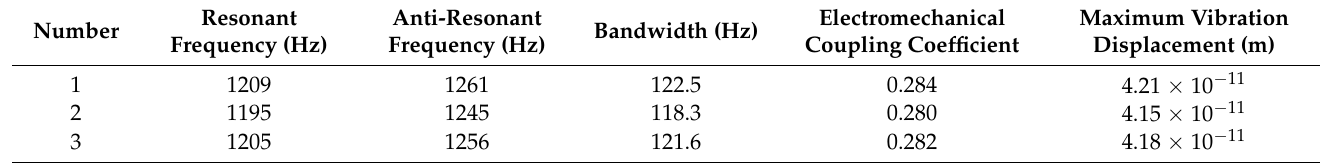
Figure 10. The Aligent 4294 impedance analyzer. Table 2. Performance test results of 2-2 piezoelectric composite vibrators.